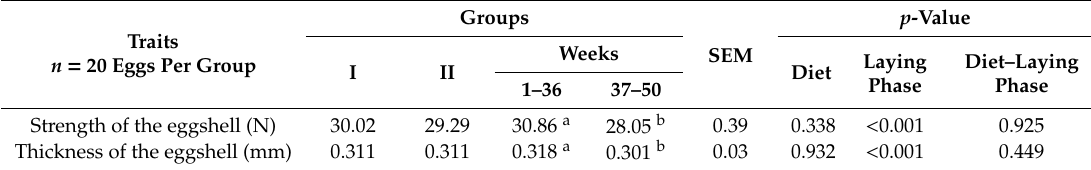
Table 7. Parameters of eggshells.